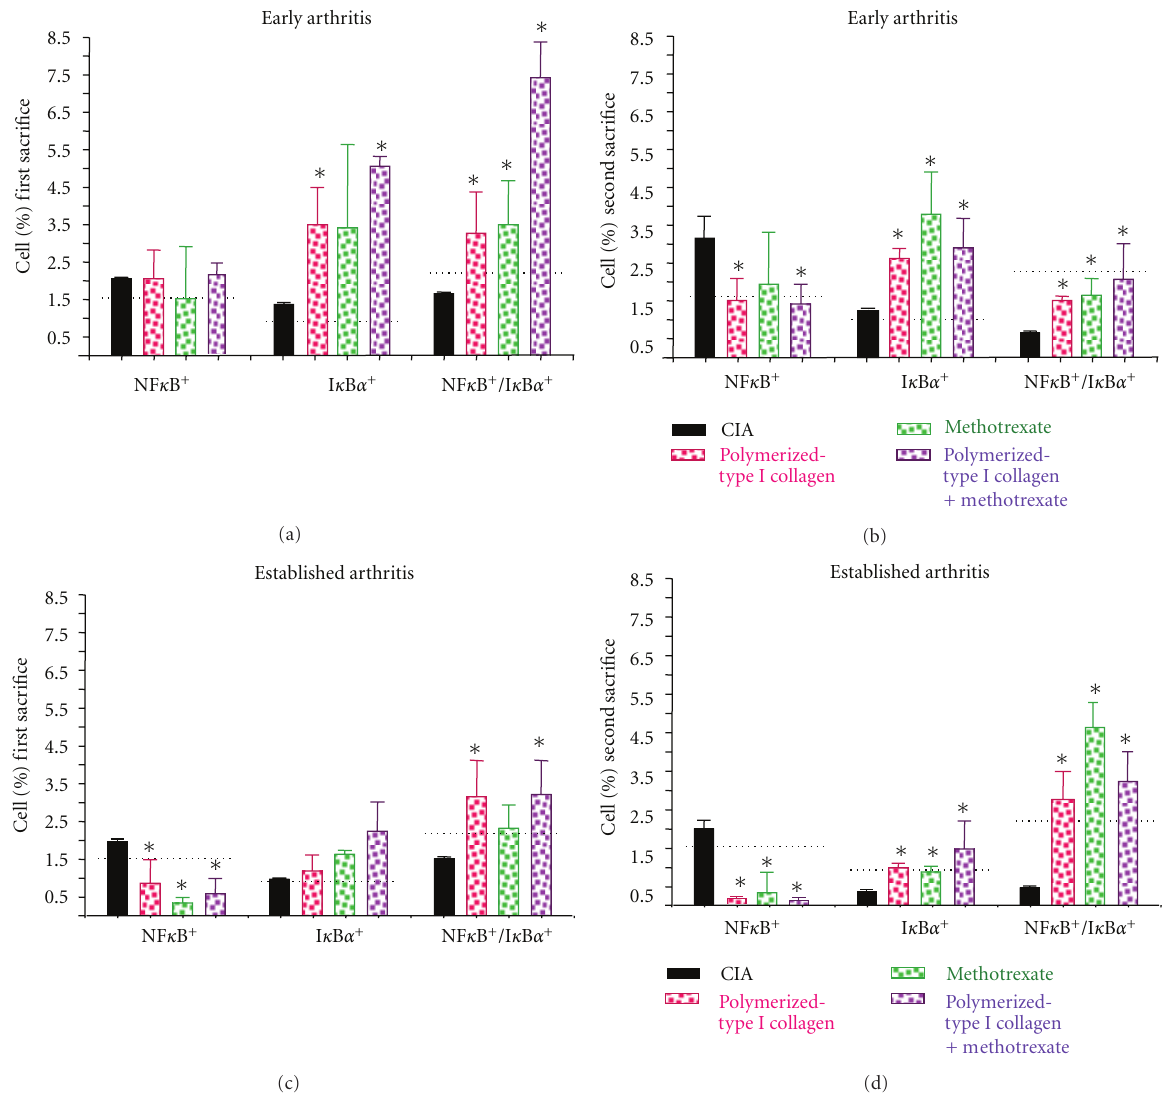
Figure 5: E ff ect of polymerized-type I collagen on the ex vivo NF- κ B and I κ B- α in splenocytes. (a) Spleen cells obtained immediately ex vivo in early arthritis model on day 35 after booster immunization. (b) Splenocytes obtained immediately ex vivo in early arthritis model on day 98 after booster immunization. (c) Spleen cells obtained immediately ex vivo in established arthritis model during first sacrifice. (d) Splenocytes obtained from established arthritis model during second sacrifice. Intracellular levels of NF- κ Bp65 and I κ B α cells were detected by flow cytometry. Results are representative of 6 mice analyzed in each group. Horizontal dotted line represent mean normal values, obtained from mice ( n = 3) without CIA. Data represent mean ± SEM. ∗ P < 0 .